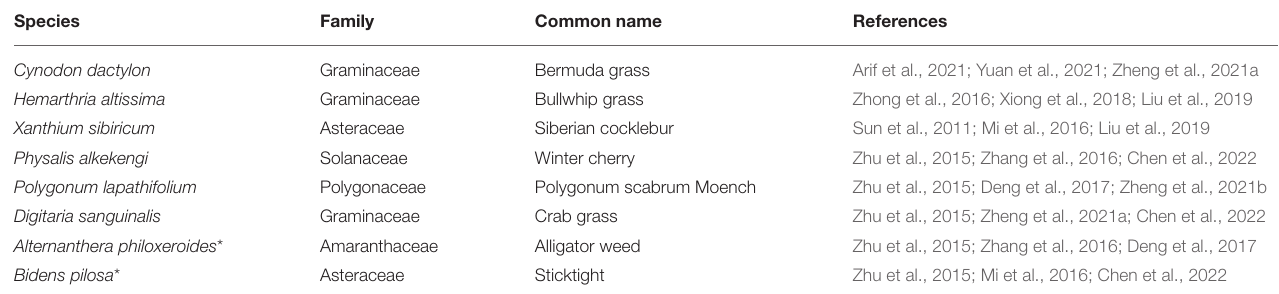
TABLE 1 | An overview of selected species used in the riparian zone of the Three Gorges Reservoir, China.